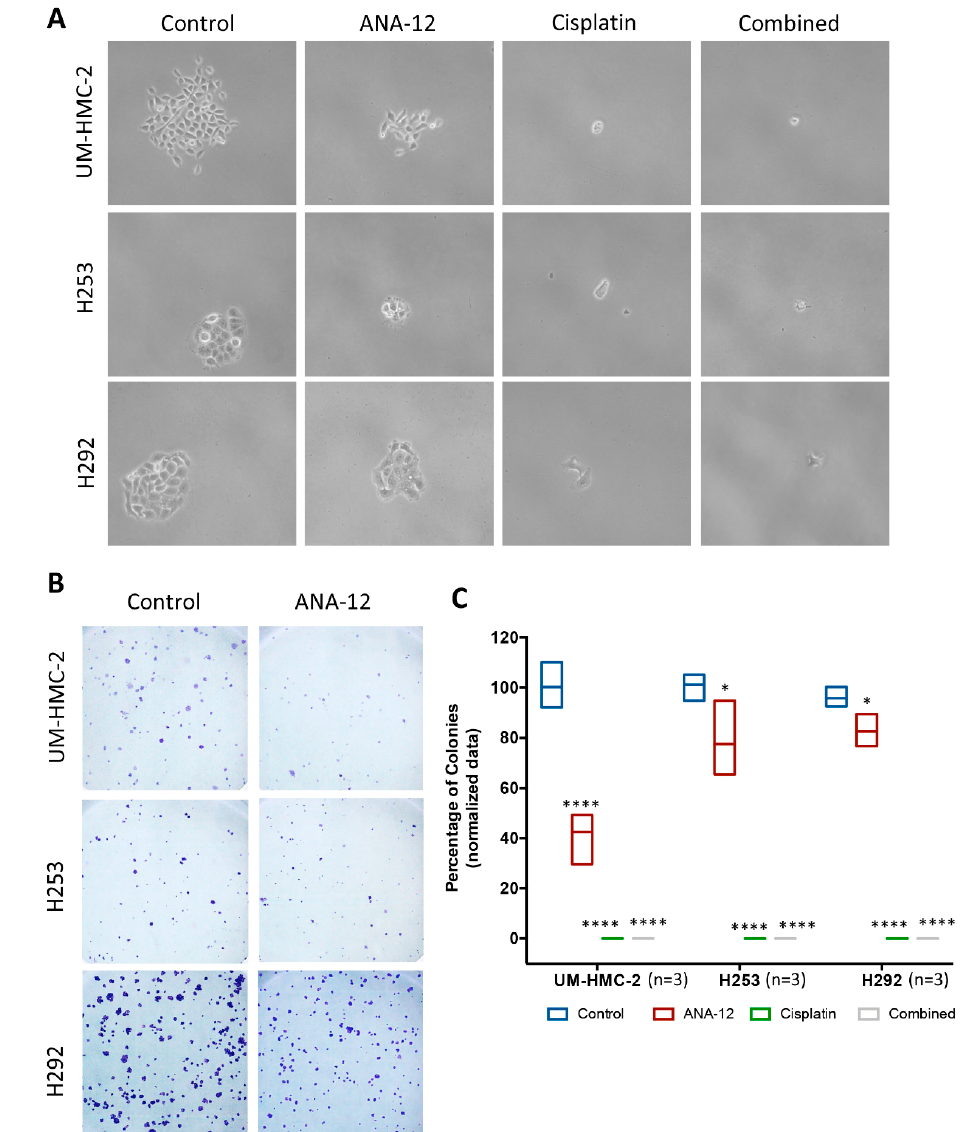
Figure 5. ( A ) Representative images of phase contrast microscopy during the clonogenic assay. Note that under Cisplatin and combined treatment, MEC cells remained attached and with a healthy morphology, but did not present the capacity to form colonies. ( B ) Comparison of stained colonies in control and ANA-12 groups. Note that the number and size of colonies is reduced following TrkB inhibition. ( C ) Quantitative analysis revealed a significant reduction in the number of surviving colonies (more than 50 cells) in all MEC cell lines (* p < 0.05; **** p < 0.0001). The tumour spheroid assay demonstrated that ANA-12 was efficient in disrupting the CSC population. The number of spheroids was significantly reduced, following TrkB inhibition in all MEC cell lines (Figure 6A,B). Surprisingly, in the present study, Cisplatin significantly disrupted the capacity to form spheroids in all MEC cell lines, this was in contrast to previous results that demonstrated a more limited effect [10]. An insignificant number of spheroids were formed, following Cisplatin administration, and they had a looser morphology compared to control spheroids (Figure 6A,B). Interestingly, but disturbingly, the combination of drugs allowed the recovery of colony formation by all MEC cell lines, under low-attachment conditions, suggesting